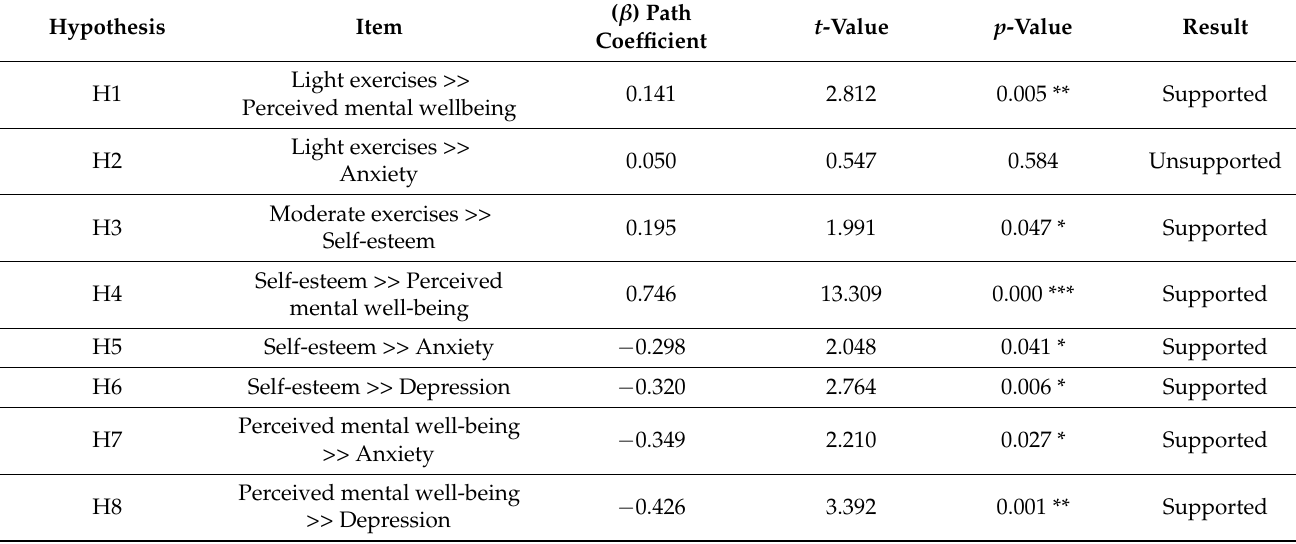
Table 5. Results of hypotheses